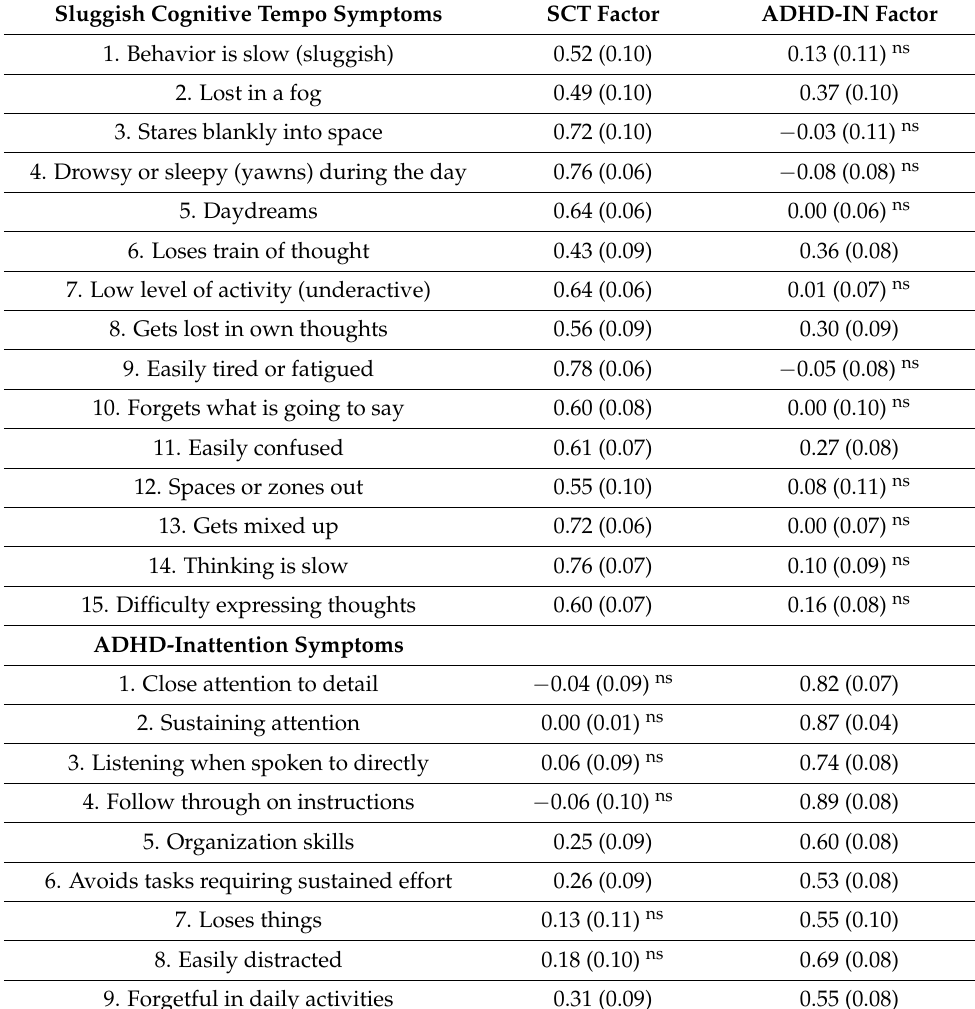
Table 1. Standardized Primary and Secondary Factor Loadings (standard errors) of Sluggish Cog- nitive Tempo (SCT) and ADHD Inattention (IN) Symptoms on Sluggish Cognitive Tempo and ADHD-Inattention